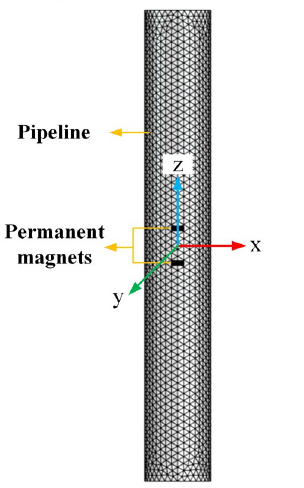
Figure 8. The simulation model.